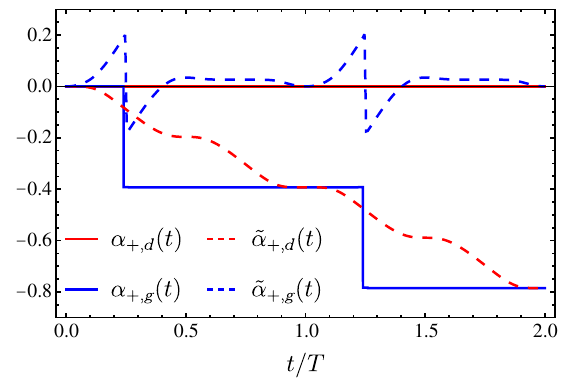
FIG. 4. A comparison of the geometric and dynamical phases generated by state | φ + ( t ) (cid:2) . The variables with (without) a tilde correspond to the dynamical (geometric) X π/ 2